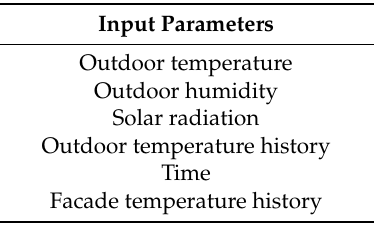
Table 1. Input parameters for the facade temperature